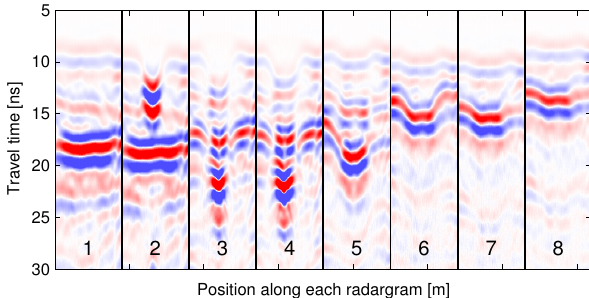
Figure 11. Excerpts from the eight radargrams in Fig. 10 to high- light the infiltration process during experiment 2. Each part shows the same 3m stretch centered around